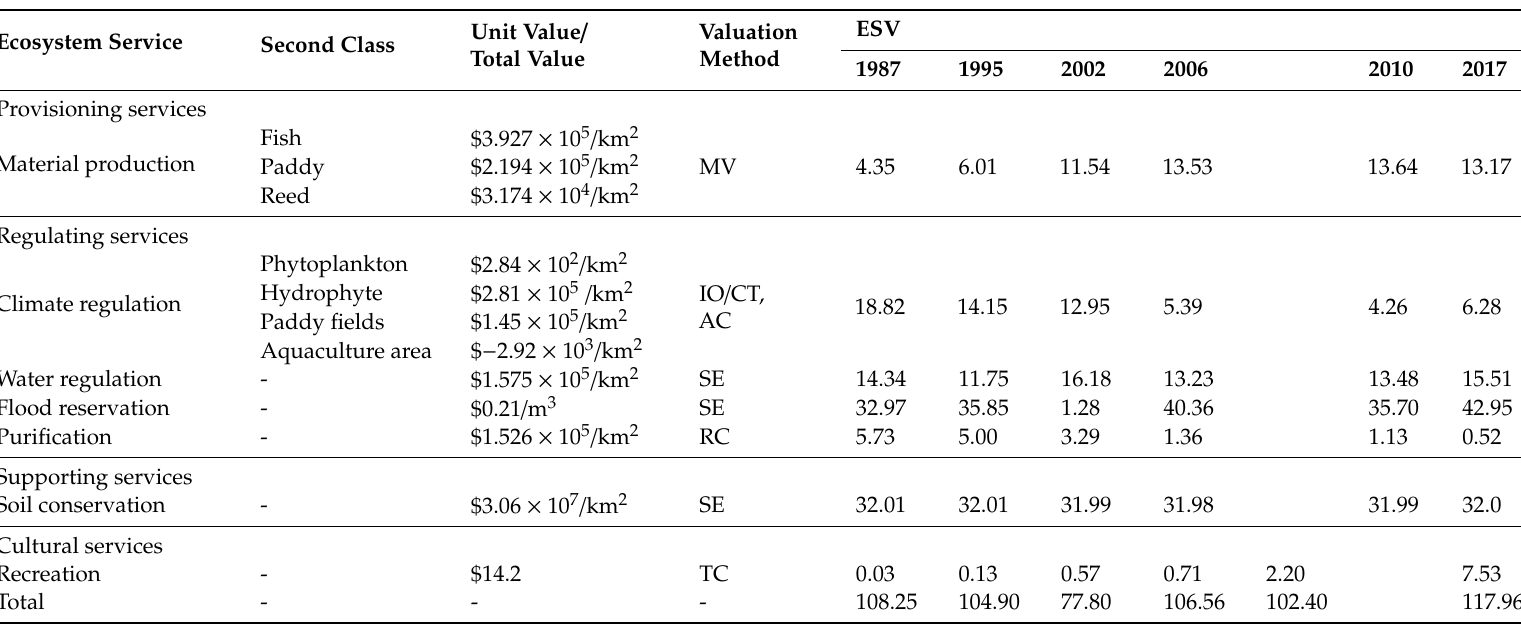
Table 6. The unit values of ecosystem services (ES) and total ecosystem services value (ESV) in Nansi Lake wetland from 1987 to 2017 (10 million dollars, values